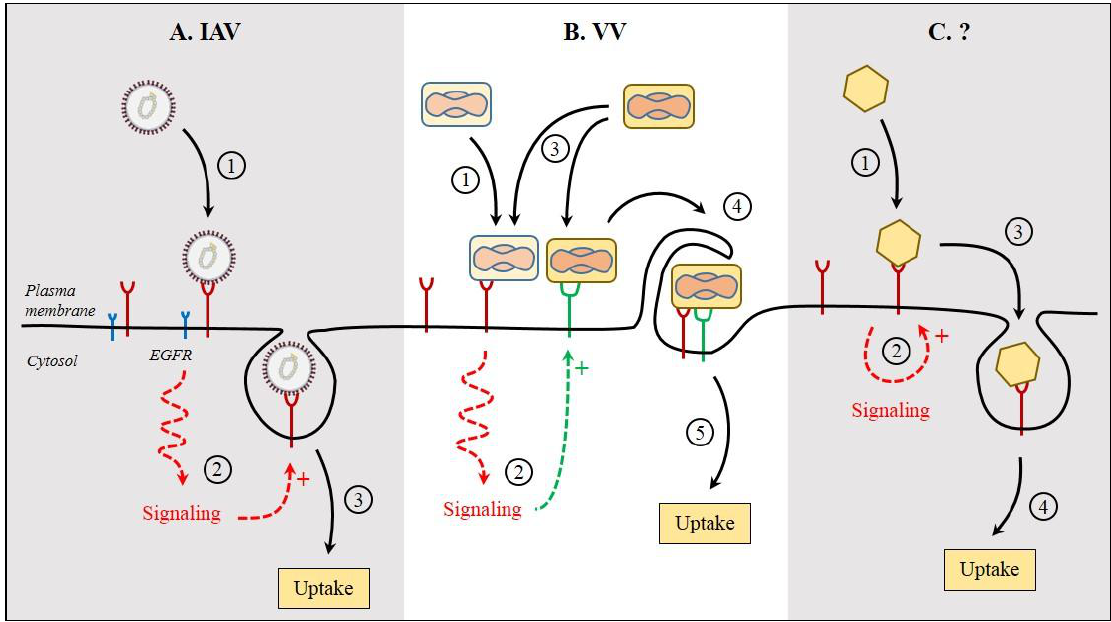
Figure 3. Signaling during virus entry. Infections cause profound perturbations of the host cell signaling networks. Signaling likely begins at the plasma membrane, after virus binding to receptors. Here are few examples of signaling during virus entry. ( A )